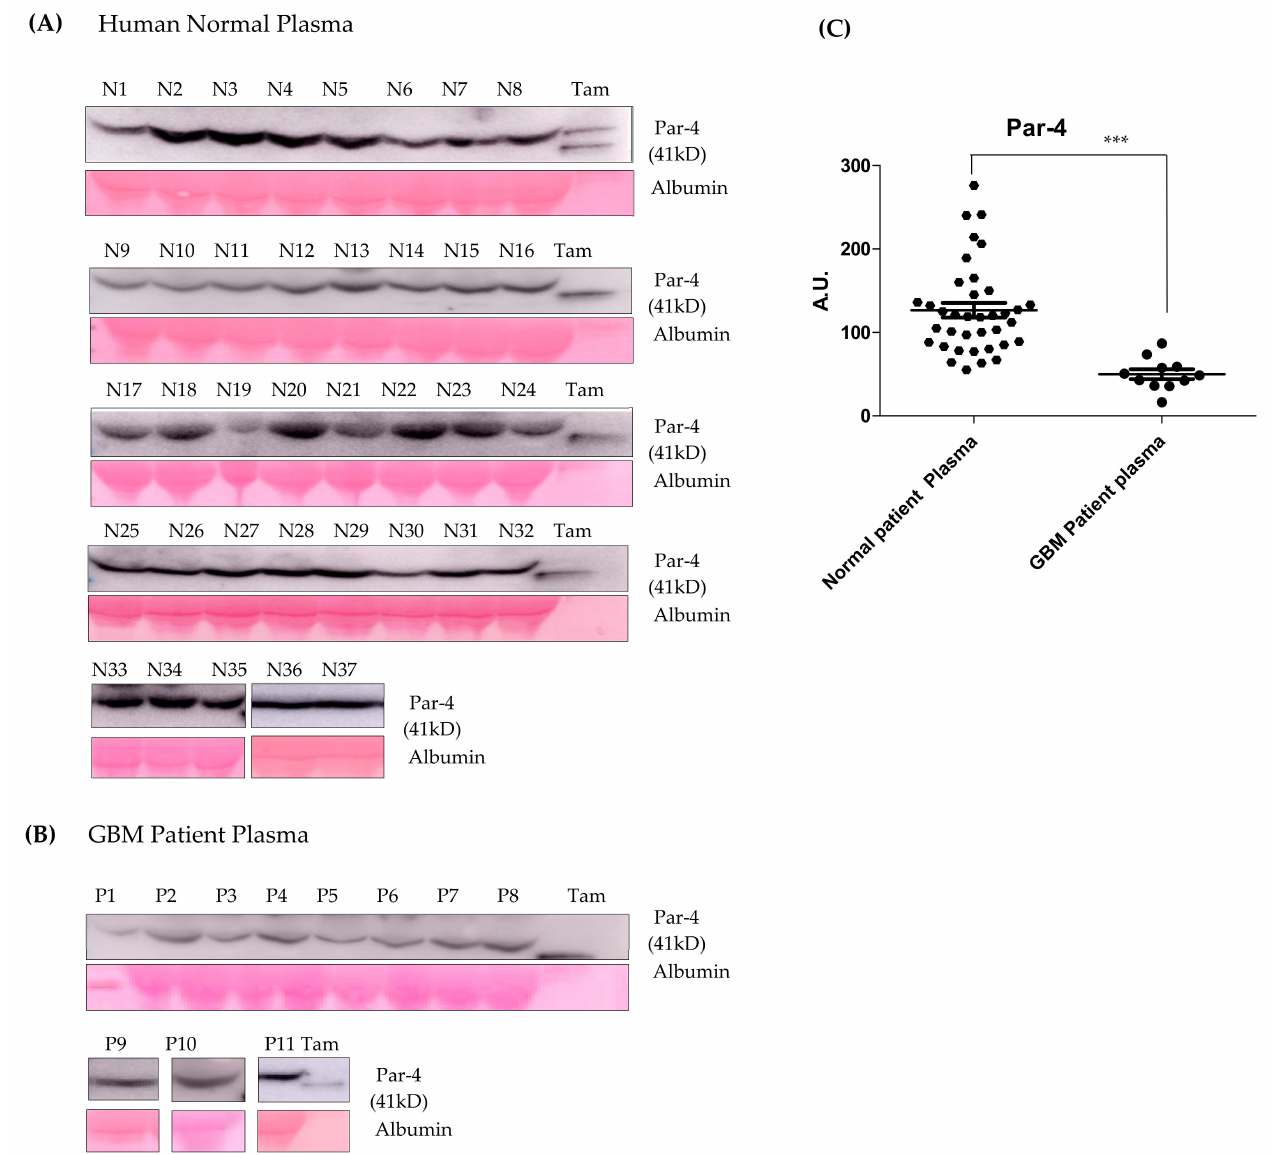
Figure 9. ( A , B ) The western blot for Par-4 estimation in the plasma samples of normal volunteers and GBM patients using an Image J software. Albumin and Ponceau stained blots were considered for normalization. ( C ) Scatter plot representing average Par-4 levels in normal and GBM patient plasma. Tamoxifen (Tam) treated cell- supernatant was used as a positive control. Statistical significance for Par-4 levels between normal and GBM patients was determined using ANOVA followed by the post hoc Tuckey test (*** p ≤